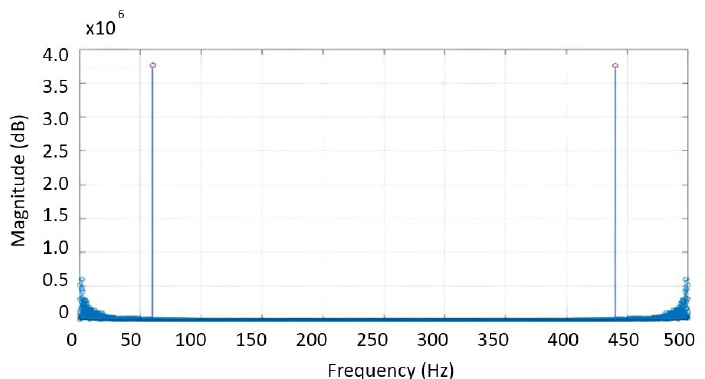
Figure 12. Frequency Spectrum of the EOG signal from FFT; according to this the cut-off frequency for the design of the digital filter is 60 Hz.